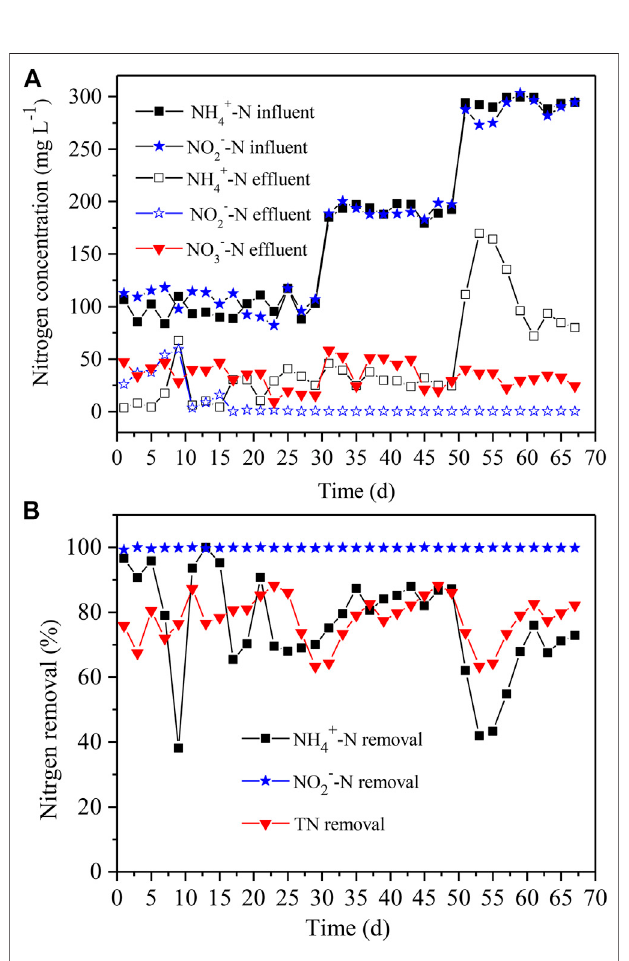
FIGURE 5 | The ef fl uent (A) and nitrogen removal (B) in the anammox reactor with distinct NH 4+ -N and NO 2 − -N levels of in fl uent. The NH 4+ -N and NO 2 − -N concentrations varied from 100, to 200, to 300 mg L − 1 . TN removal denotes the removal rates of total nitrogen.